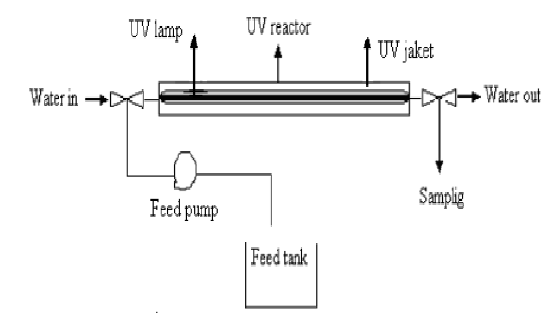
Figure 1. Plan of the experimental